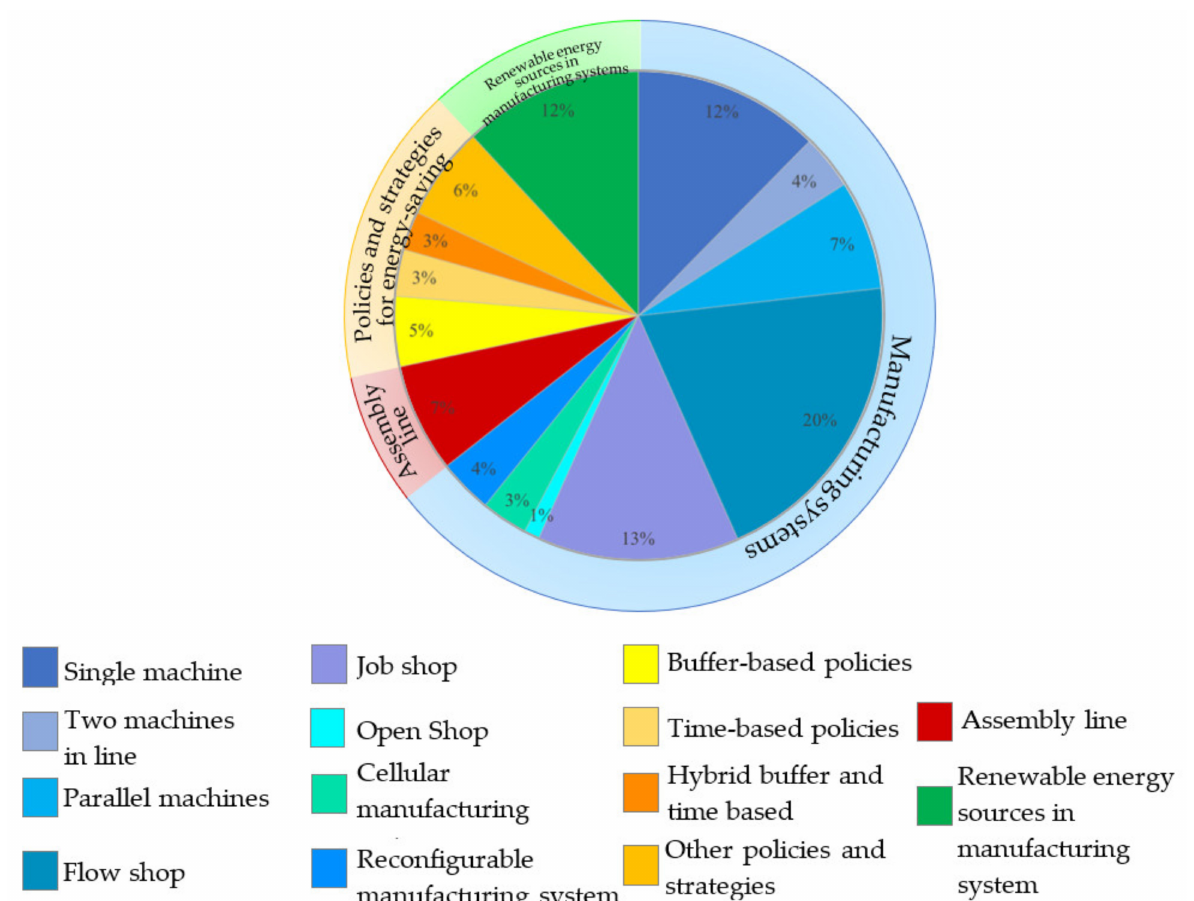
Figure 3. Percentage of papers in each